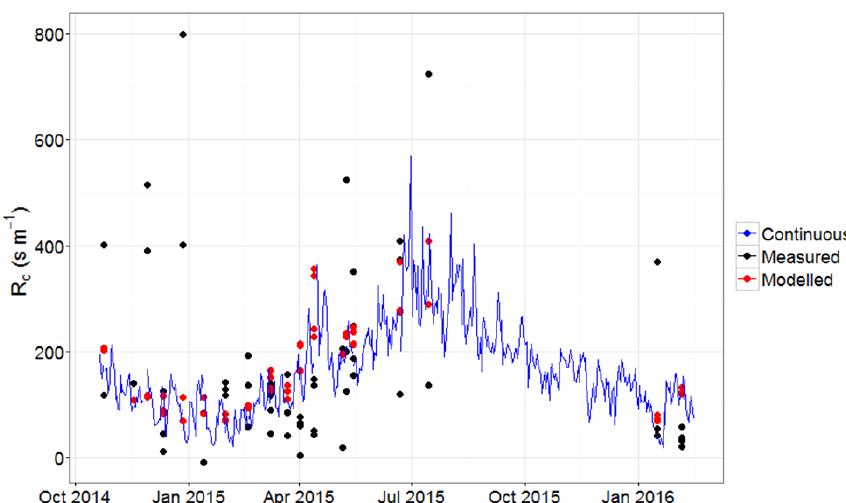
Figure 2. Time series of time-integrated COTAG R c measurements and Eq. (4) R c estimates. The blue line represents continuous R c estimates calculated from the daily mean T and RH measurements at the field site. Black points are the measured R c values from the COTAG systems, and the red points are the modelled R c from the same time-integrated